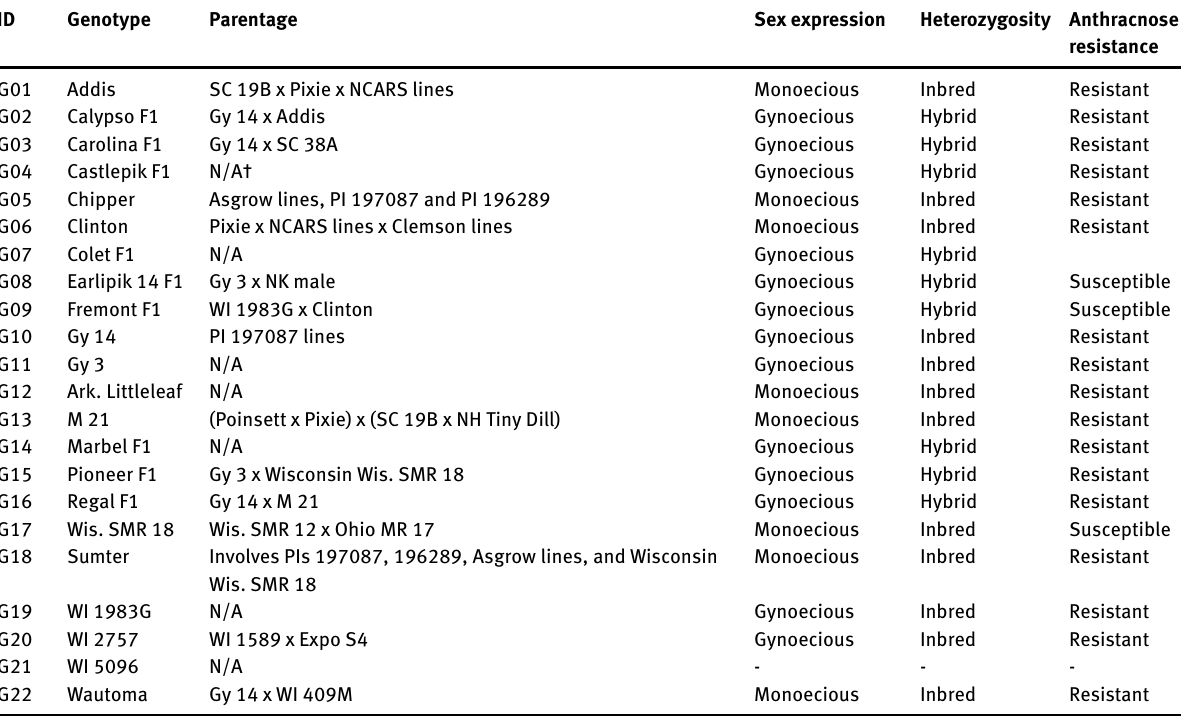
Table 1: The 22 cucumber genotypes tested with pedigree and general